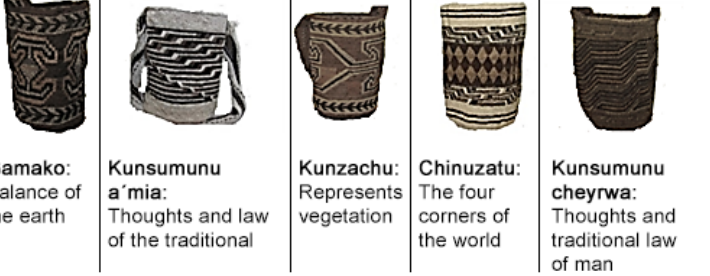
Figure 7. Arhuaco designs used in the weaving and knitting of the bag. Photos by Dwrya Izquierdo